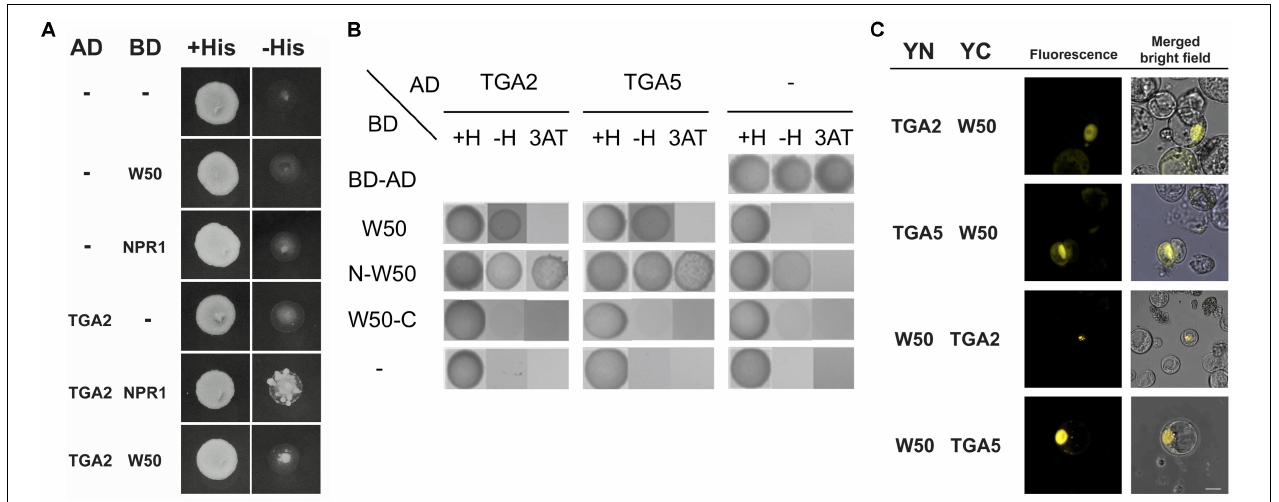
FIGURE 5 | AtWRKY50 interacts with TGA2 and TGA5. (A) Yeast was transformed with expression plasmids pAS2.1 and pACT2, containing the coding regions of the binding domain (BD) and activation domain (AD) of GAL4, respectively. The BD domain was either fused to the coding regions of AtWRKY50 (W50) or NPR1, or was not fused (minus sign); the AD domain was not fused (minus sign) or was fused to the coding region of TGA2. Growth of transformed yeast was evaluated on medium containing histidine (+His) or minus histidine (–His). (B) The N-terminal of AtWRKY50 interacts with TGA2 and TGA5. Yeast was transformed with expression plasmids pAS2.1 and pACT2, containing the coding regions of the binding domain (BD) and activation domain (AD) of GAL4, respectively. The BD domain was either fused to the coding regions of full length AtWRKY50 or its N-terminal or C-terminal half. The AD domain was not fused (minus sign) or was fused to the coding region of TGA2 or TGA5. Growth of transformed yeast was evaluated on medium containing histidine (+H), minus histidine (–H) and minus histidine plus 10 mM 3AT (3AT). (C) AtWRKY50 interacts with TGA2 and TGA5 in Arabidopsis protoplasts. YFP fluorescence and merged bright field images of Arabidopsis protoplasts co-transformed with expression plasmids containing constructs encoding TGA2, TGA5, and AtWRKY50 (W50) fused to the N-terminus (YN) or the C-terminus (YC) of yellow fluorescent protein. Scale bar = 10 µ m.